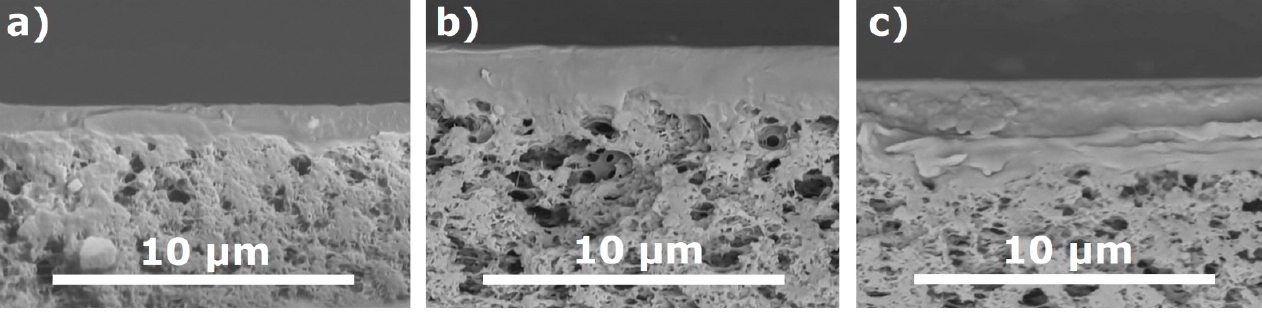
Figure 4. SEM image of a transverse cleavage of PTMSP/MFFK-1 membranes obtained by applying different volumes of PTMSP solution (0.50 wt %) at a rotation speed of 750 rpm: ( a ) 1.0 mL, ( b ) 1.5 mL and ( c ) 2.0 mL.